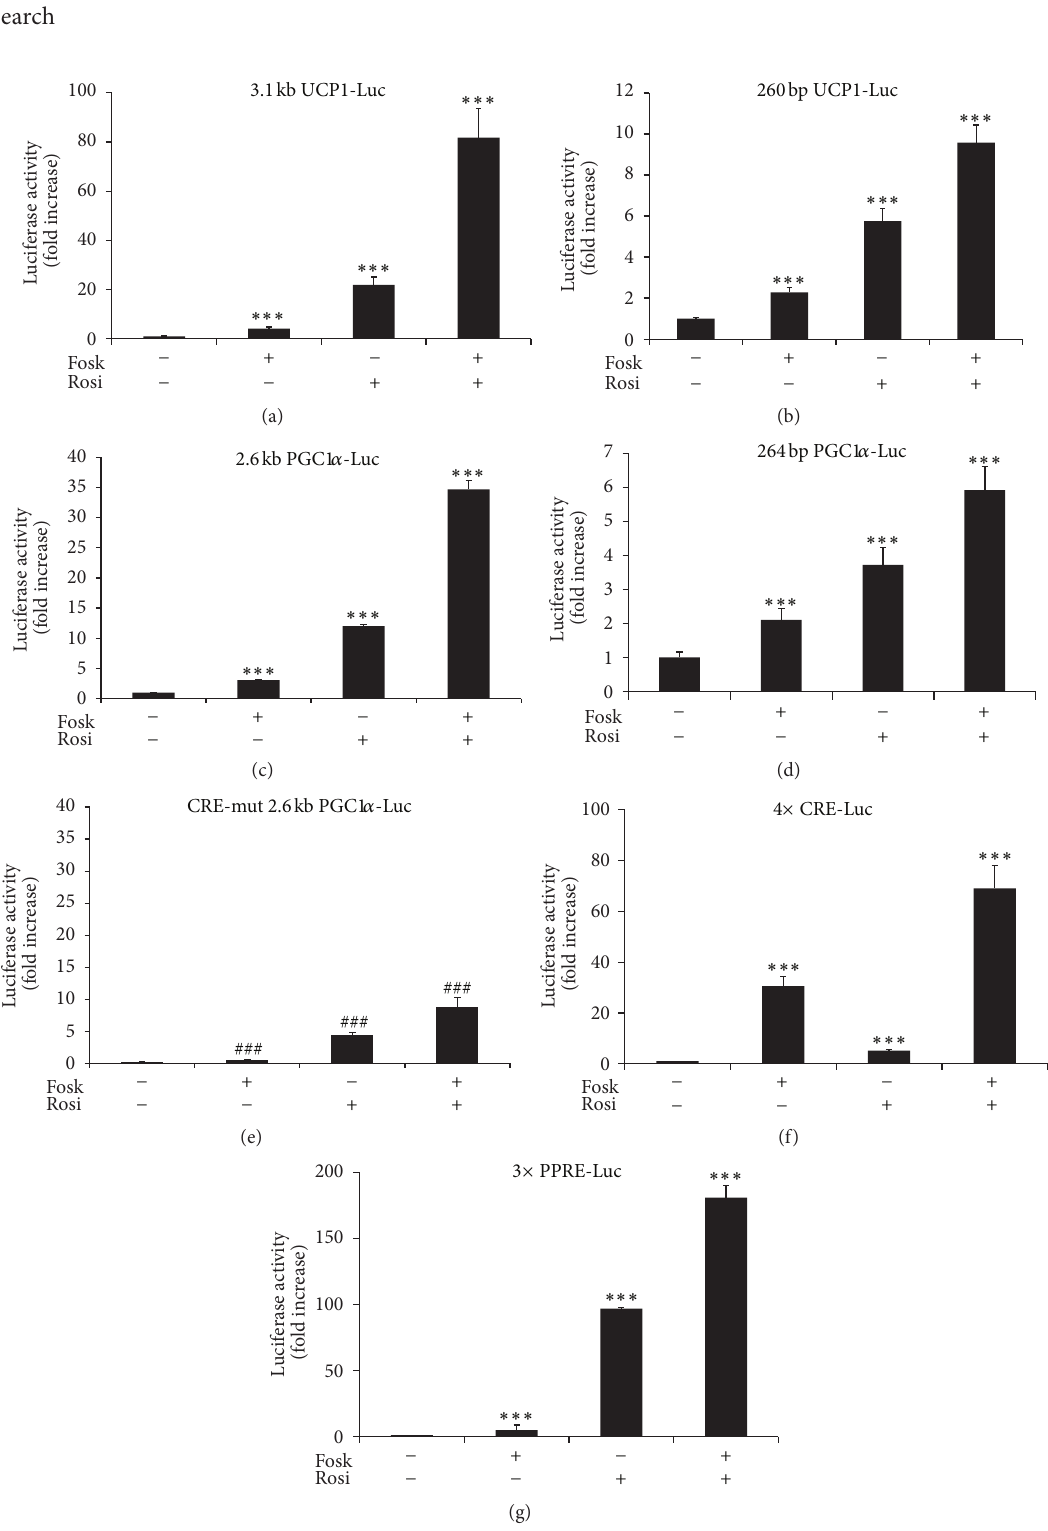
Figure 2: Luciferase reporter assay showing the effect of forskolin and rosiglitazone on (a) 3.1kbp UCP1-Luc, (b) 260 bp UCP1-Luc, (c) 2.6 kbp PGC1 𝛼 -Luc, (d) 264 bp PGC1 𝛼 -Luc, (e) CRE-mut 2.6 kbp PGC1 𝛼 -Luc, (f) 4 × CRE-Luc, and (g) 3 × PPRE-Luc, promoter activities. HIB-1B cells were grown to confluence and then transiently transfected with the above -pGL3-Luc reporter construct, as indicated. Twenty-four hours later, cells were treated with DMSO (control), rosiglitazone (10 𝜇 M) for 24 hours, or forskolin (10 𝜇 M) for the final 12 hours of rosiglitazone treatment, in serum-free medium, before luciferase activity was measured. Values were expressed as fold increase of ratio of firefly to renilla. Errorbarmeansthemean ± sem.ofthreeobservationswithinasingleexperimentperformedintriplicate. ∗∗∗ Significantdifference 𝑃 < 0.001 , respectively, with respect to control; ### significant difference 𝑃 < 0.001 from wildtype due to the mutation of